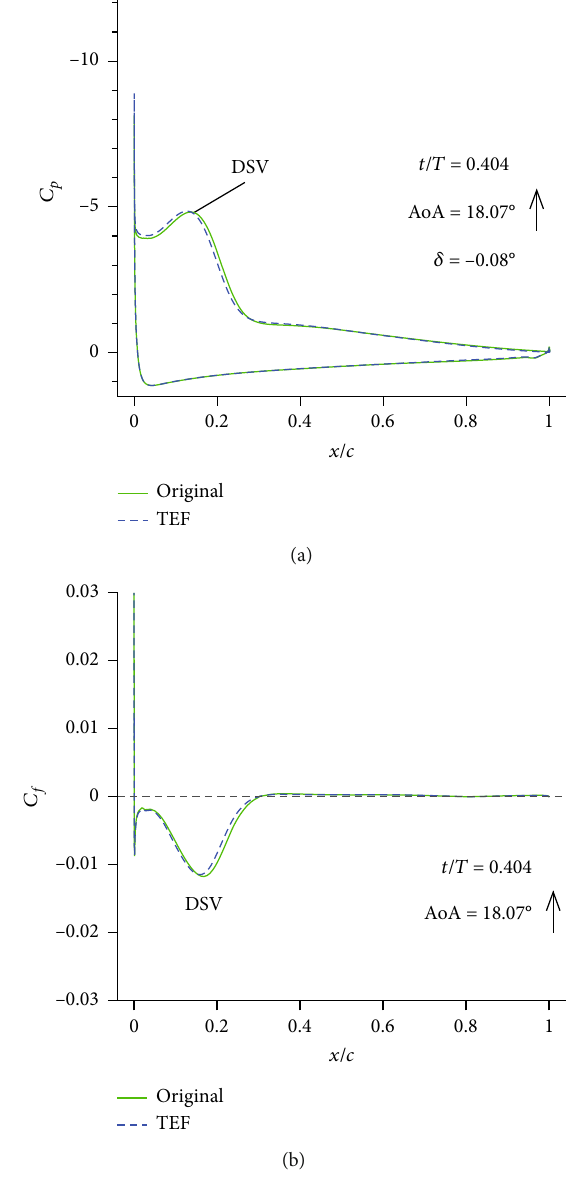
Figure 14: Comparison of coe ffi cient distributions at the angle of attack of 15.27deg upstroke: (a) pressure coe ffi cients and (b) skin friction coe ffi cients on the upper